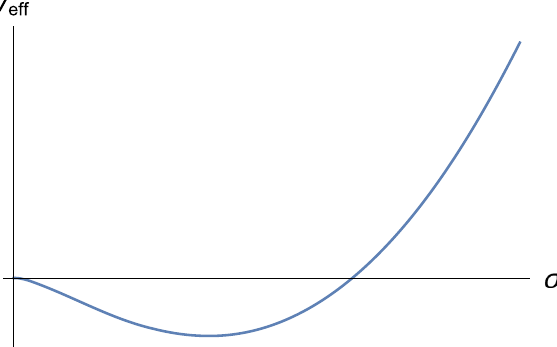
Fig. 1 Tadpole graph with two insertions of the vertex b 1 ¯ ψ i γ i ∂ i ψ . The continuous and dashed lines stand for the propagators for the fermion and